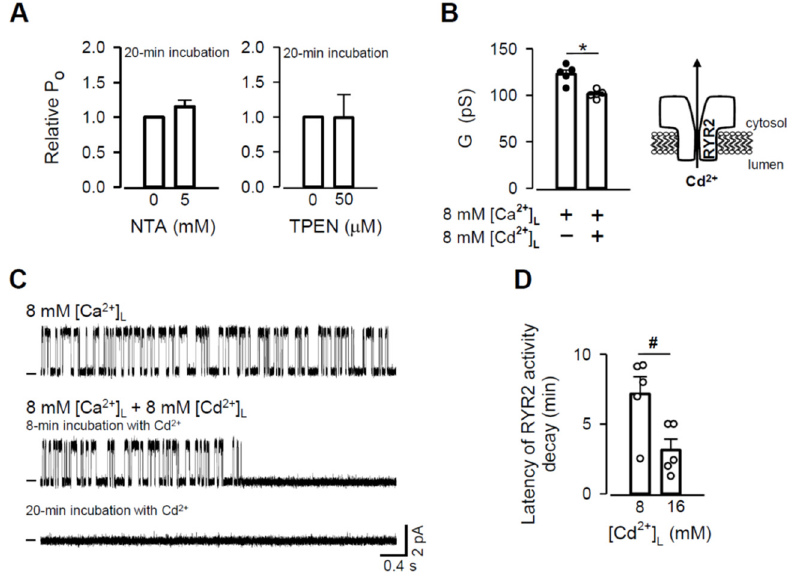
Figure 7. Zn 2+ displacement from the RYR2 Zn 2+ finger. ( A ) Effects of NTA (left panel) and TPEN (right panel) added to the cytosolic solution on RYR2 P O as a consequence of a decrease in [Zn 2+ ] C (paired Student’s t test). ( B ) The effect of Cd 2+ addition (8 mM) on the RYR2 G under near-saturating conditions when 8 mM [Ca 2+ ] L was present. * Significantly different from the control values when only luminal Ca 2+ was present (paired Student’s t test). ( C ) Representative RYR2 currents, shown as upward deflections from the marked zero-current level, for 8 mM [Ca 2+ ] L (control, top trace) and when 8 mM [Cd 2+ ] L was added (two bottom traces). RYR2 channels were activated by 1–2 mM caffeine in the presence of 90 nM free [Ca 2+ ] C . Current recordings were conducted at 0 mV and are from the same channel. ( D ) Latency of RYR2 activity decay as a function of [Cd 2+ ] L . # Significantly different from 8 mM [Cd 2+ ] L (unpaired Student’s t test). Data shown are average ± SEM of 5–7 experiments. Data points shown in ( B ) and ( D ) are individual measurements (Ca 2+ –black circle and Cd 2+ /Ca 2+ – white circle).